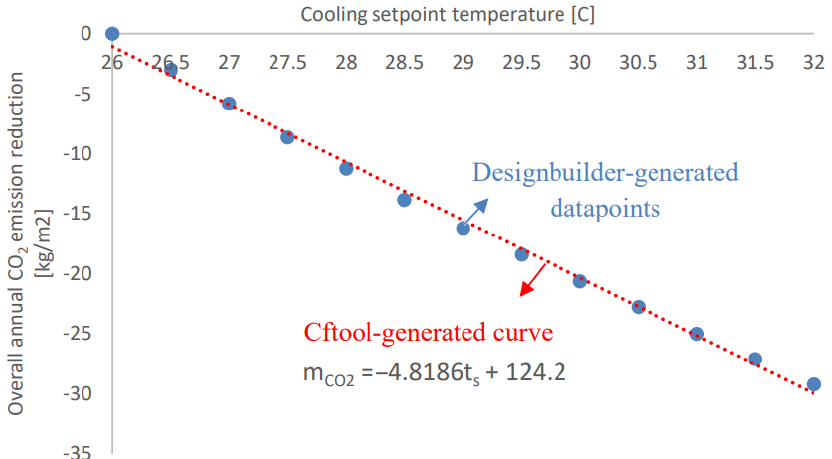
Figure 7. CO 2 emission reduction with respect to increasing the cooling setpoint temperature compared to the ASHRAE-based cooling setpoint (26 °C ).